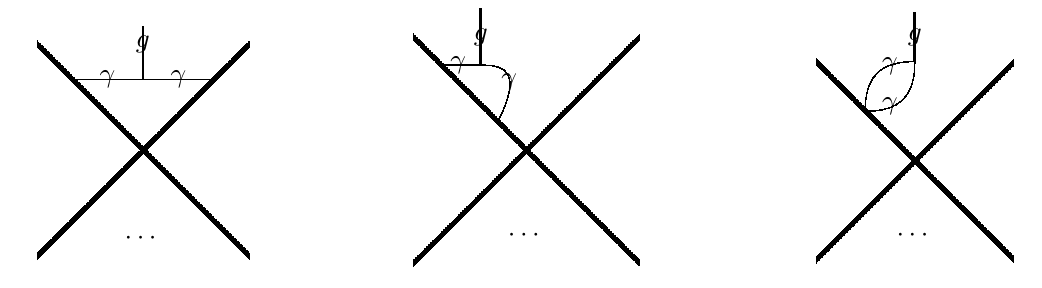
Figure 19 . Diagrams containing graviton-photon-photon vertex that contribute to the soft photon contribution to the soft graviton theorem.